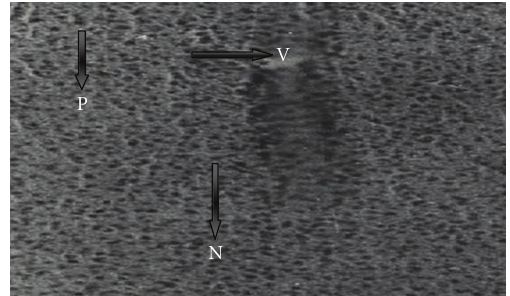
Figure 8: Plate of photomicrograph of liver of Clarias gariepinus after 12 weeks of exposure to 22ppb of gammalin 20 showed mild necrosis, swelling of blood vessels, pyknosis, and